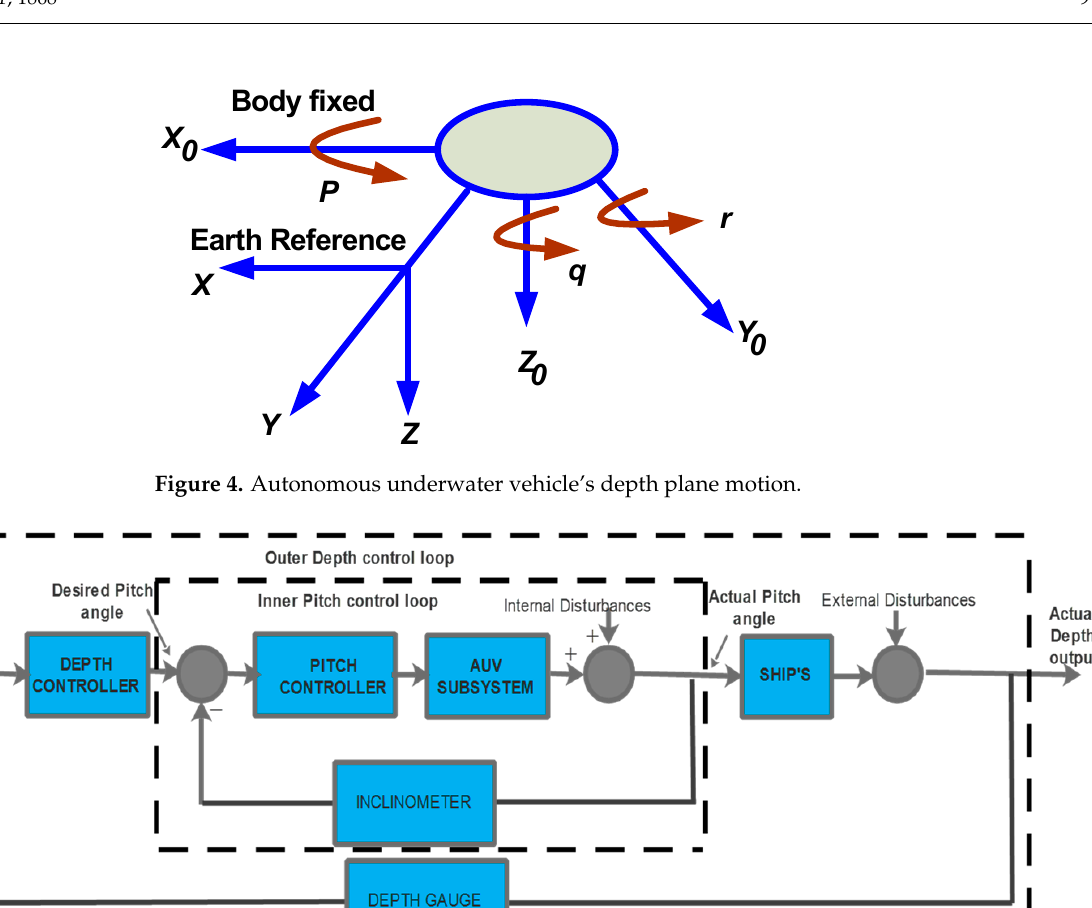
(33) The heading plane control loop depicted in Figure 3 states that the inner control loop governs the autonomous underwater vehicle’s rudder angle, while the outer control loop governs the heading angle. Figure 3. Control loop of heading plane . The control law is created in a way that forces the autonomous underwater vehicle to travel in the fi xed direction that is desired and to stay there. The orientation of the rudder in the inner control loop is the control input that helps the autonomous under- water vehicle stay pointed in the right direction. However, the rudder’s ability to move is physically constrained. The autonomous underwater vehicle’s unbalance may result from high yaw rates, which can also cause roll and sway motion. As a result, the rudder angle of the autonomous underwater vehicle completely determines how the outer con- trol loop measures the heading angle. Therefore, while navigating an autonomous un- derwater vehicle, restrictions must be placed on rudder orientation and yaw rate.